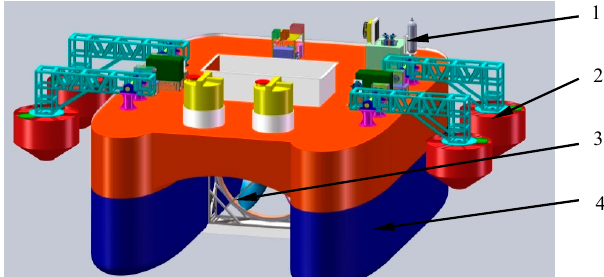
Figure 1. Schematic of floating platform of offshore ocean energy converter. 1. Hydraulic energy storage and generation parts; 2. Floating buoy and link parts; 3. Current energy capture part; 4. Movable catamaran platform.